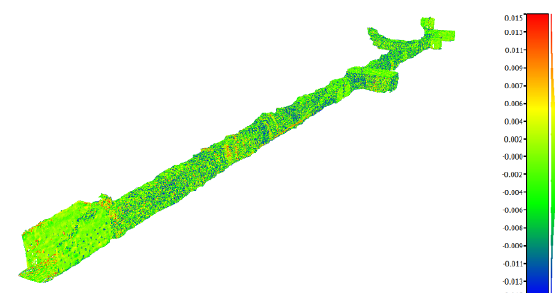
Figure 8. Signed distance error for the sharp looking methodology against the original TLS point cloud.